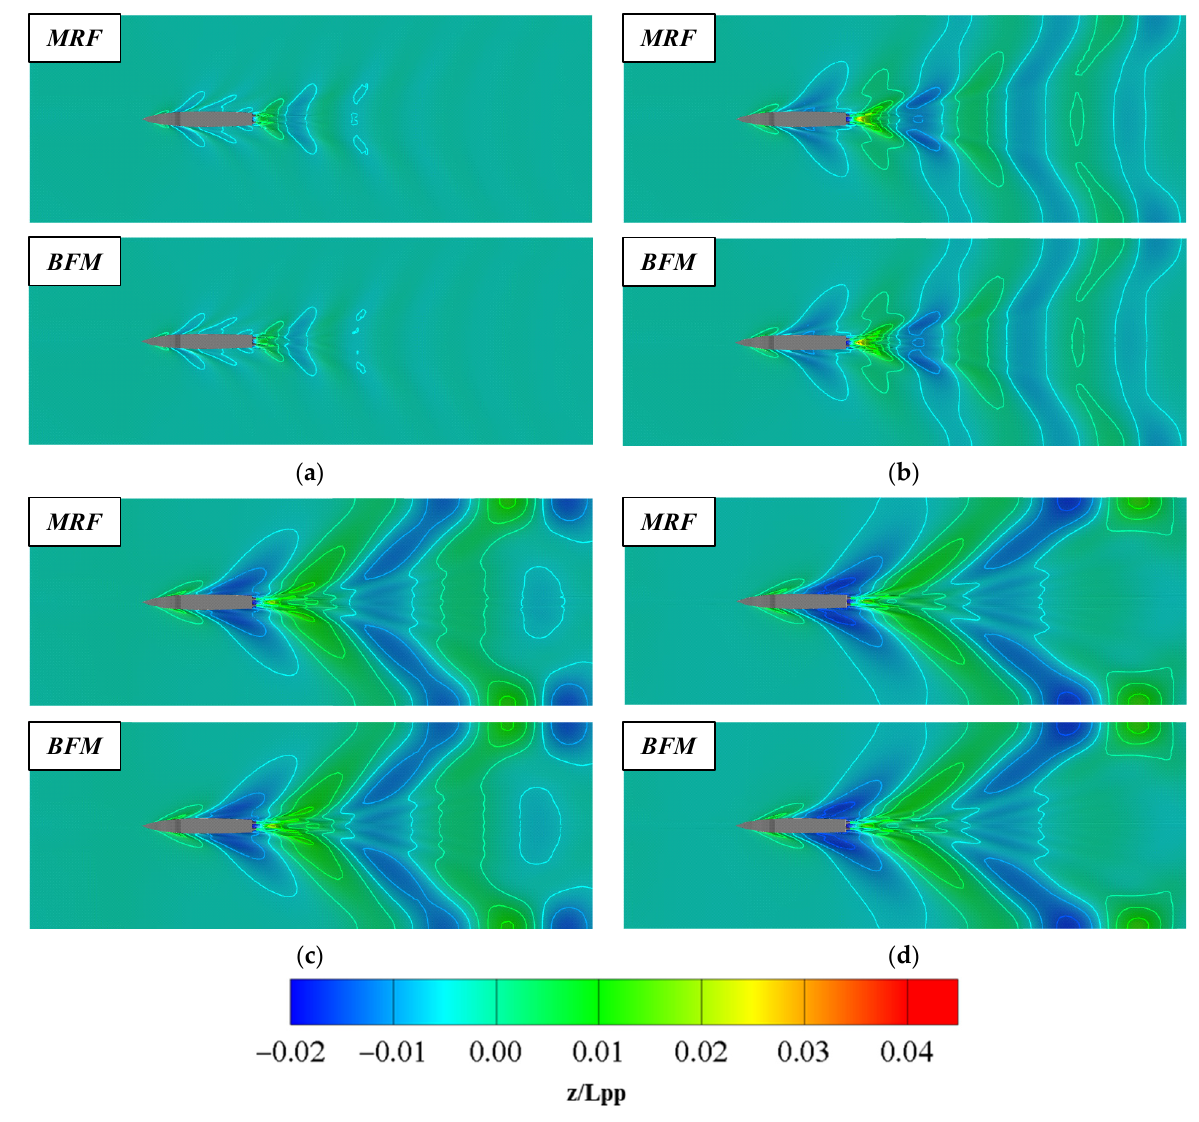
Figure 11. Wave patterns of the waterjet-propelled ship with the MRF model and body-force model (BFM). ( a ) Fr = 0.3; ( b ) Fr = 0.4; ( c ) Fr = 0.5; ( d ) Fr = 0.542. Table 4. Hull resistance of the bare hull (BH), MRF model and body-force model (BFM).